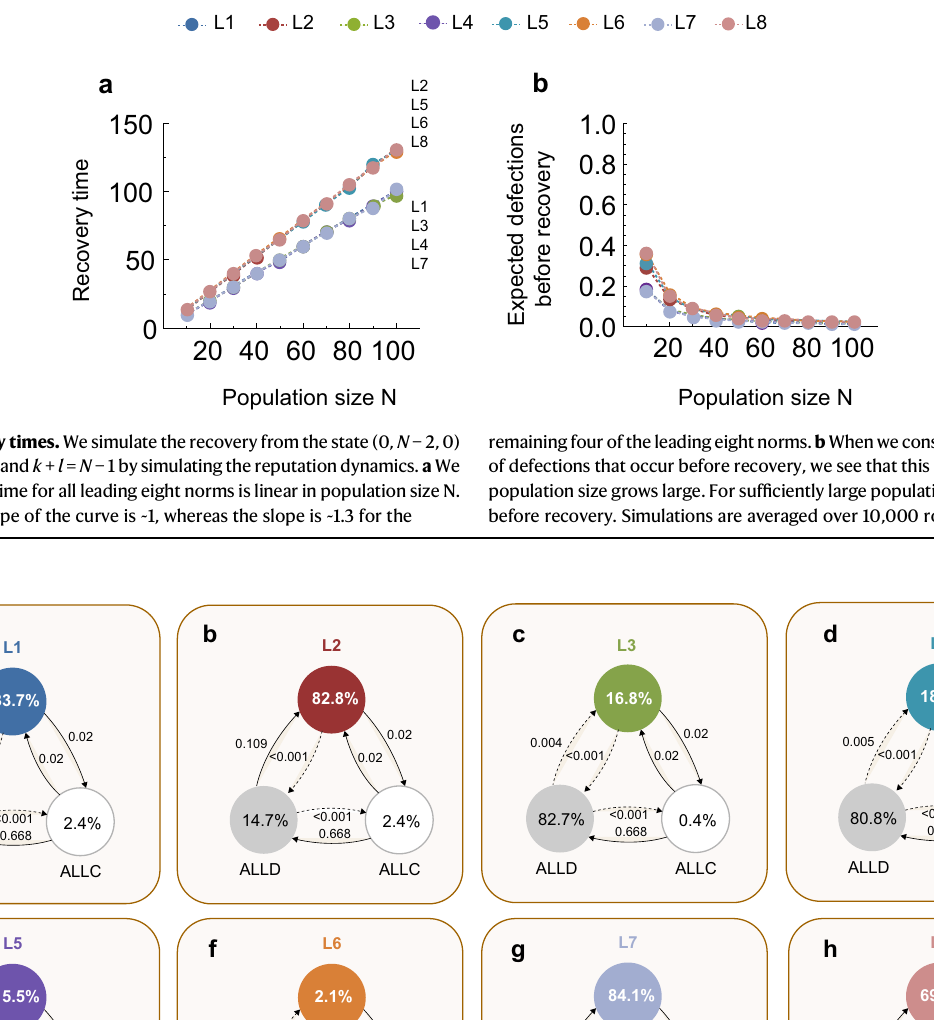
Fig. 5 | Evolution of the leading eight with quantitative assessment. We show the results of simulating evolutionary dynamics when players can choose among three different norms: a leading eight norm, ALLC , and ALLD . We assume that the spread of social norms is described by a pairwise comparison process 54 , such that normsofplayerswithhighpayoffsaremorelikelytobesuccessful.Here,weusethe limit of rare mutations, such that populations are homogeneous most of the time 57,58,85 . Numbers in circles show how often each social norm is adopted on average. Arrows indicate fi xation probabilities, i.e., how likely it is for other social